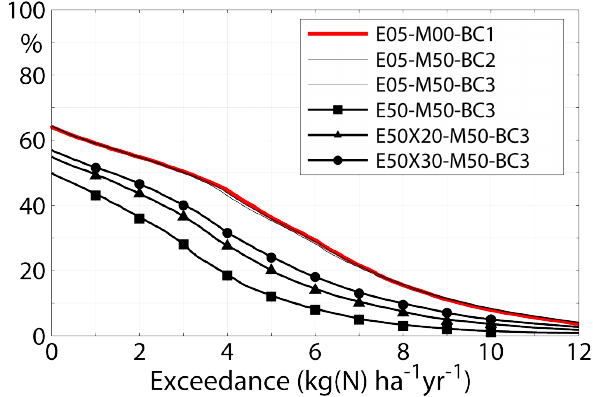
Figure 13. Inverse cumulative distribution functions of exceedances (AAE) of CL nut (N) in EU28 + for the six scenarios using the EMEP MSC-W model. Note that scenarios 2 and 3 (black thin lines) barely differ from the base